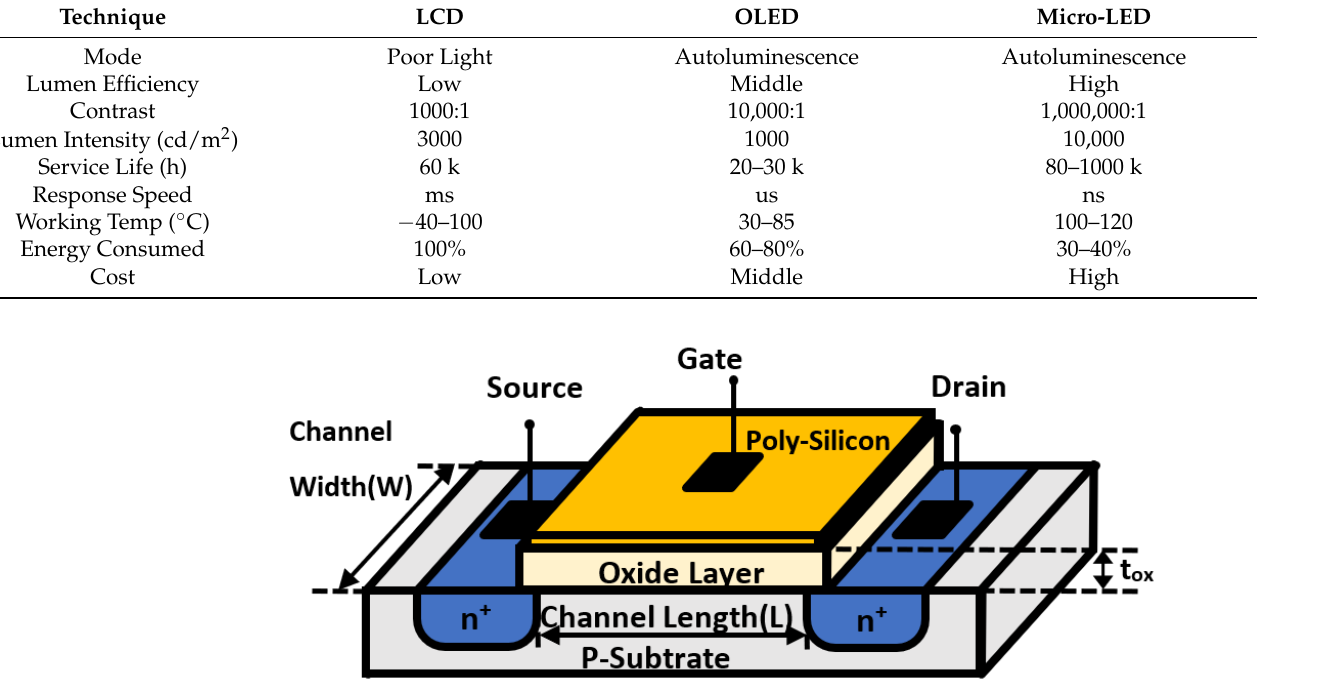
Figure 1. Physical structure of an N-channel enhancement MOSFET.